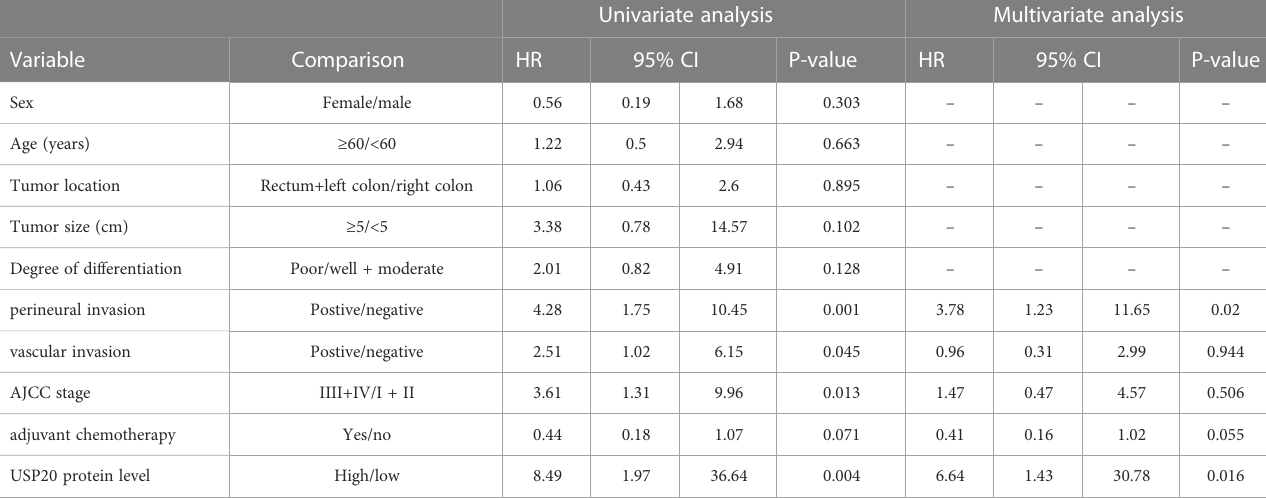
TABLE 3 Univariate and multivariate analyses of factors in fl uencing patient overall survival in the fi rst study cohort. Univariate analysis Multivariate